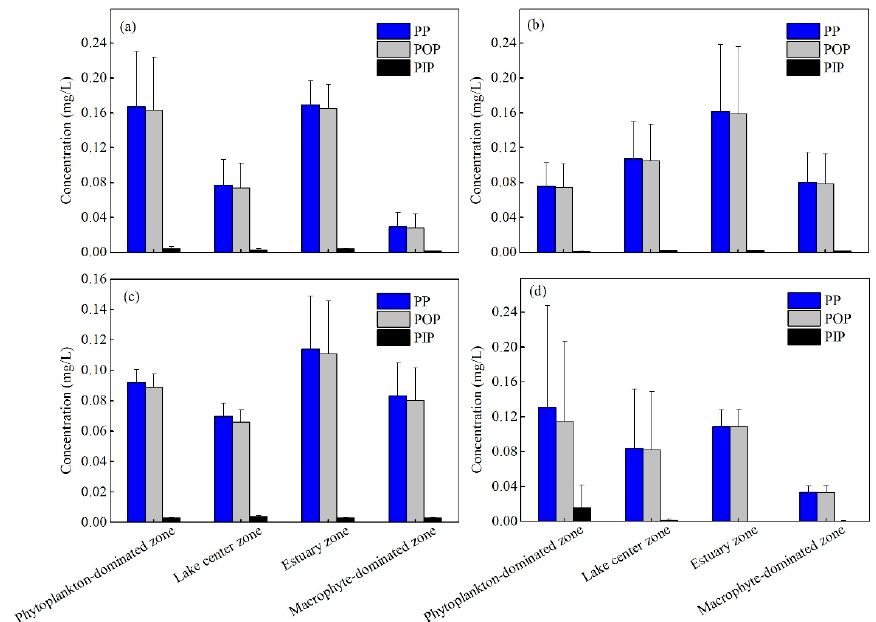
Figure 2. The temporal and spatial variability of particulate P (PP), particulate inorganic P (PIP) and particulate organic P (POP): ( a ) autumn (November 2015); ( b ) winter (February 2015); ( c ) spring (May (May 2016); ( d ) summer (August 2016). Int. J. Environ. Res. Public Health 2018 , 15 , x 2016); ( d ) summer (August 2016).